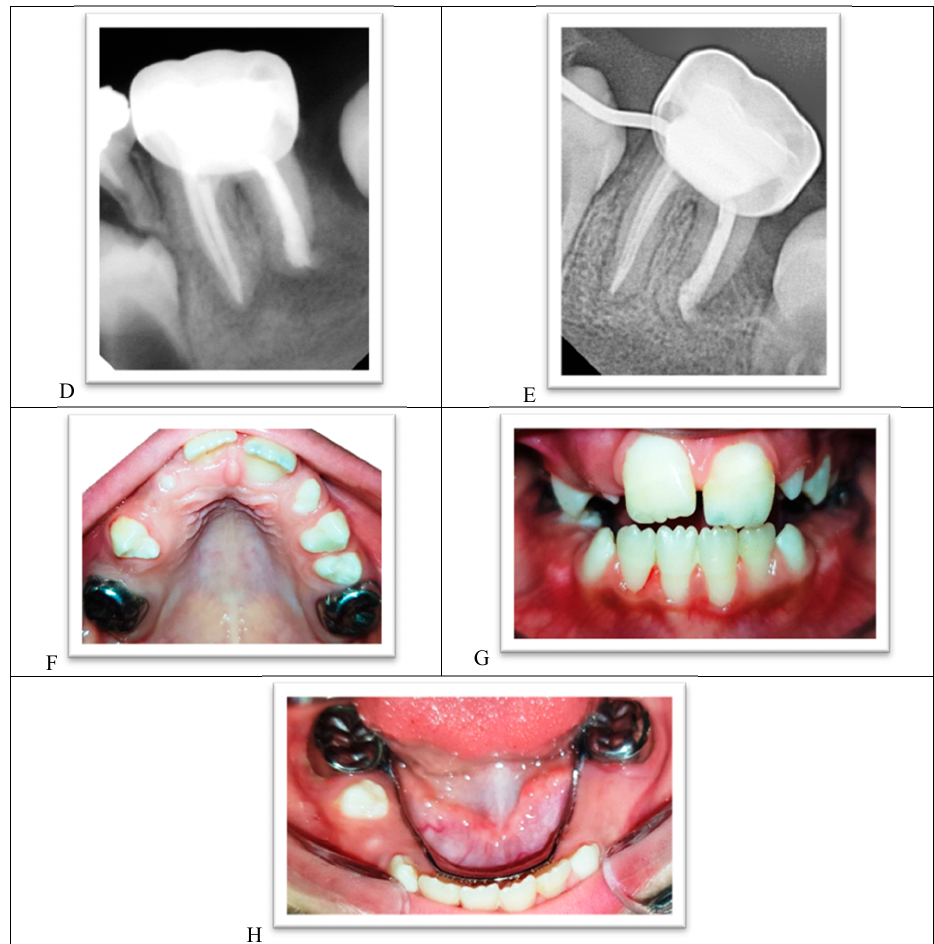
Figure 10. ( A ) A panoramic radiograph one year after treatment. ( B ) The lower-right permanent molar immediately after the treatment. ( C ) The lower-right permanent molar one year after the treatment. Note apical healing. ( D ) The lower-left permanent molar immediately after the treatment. ( E ) The lower-left permanent molar one year after the treatment. Note apical healing. ( F ) The upper arch one year after the treatment. ( G ) Both arches in occlusion. Note the reduction in an open bite. ( H ) The lower arch one year after the treatment.